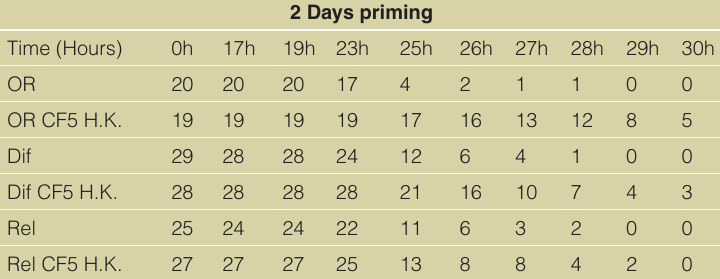
Table S3. Survival kinetics of wt and humoral response deficient flies 2 days post priming with heat-killed Pseudomonas aeruginosa CF5. Wild type Oregon R (OR) and mutant Dif and Rel flies were primed with heat-killed (H. K.) CF5 cells. Naive and primed flies were injected with the virulent PA14 strain after 2 days. Top row numbers indicate the time in hours post challenge whereas lower rows indicate the corresponding number of surviving flies in naive and primed flies respectively for each genotype. Sample size is indicated at 0h.